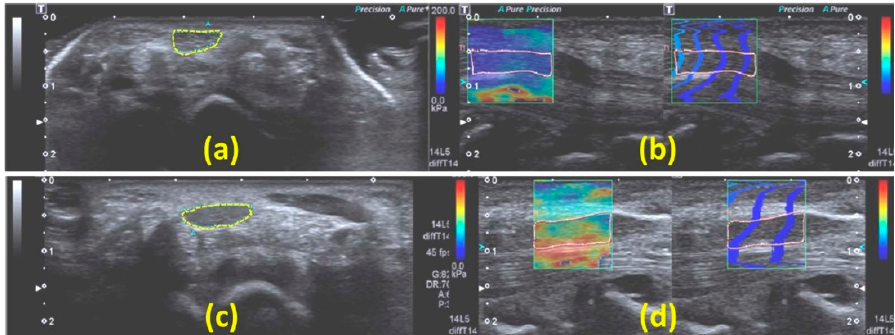
Figure 8. ( a , c ) B-mode images of the transverse plane of median nerves of a healthy subject and a CTS patient, respectively. The median nerve cross-section is identified by the dashed line. CSAs of the median nerve were 16 and 27 mm 2 for the healthy subject and CTS patient, respectively. ( b , d ) SWE-based stiffness and propagation maps from SWE on the longitudinal planes of the median nerves of the same healthy subject ( b ) and CTS patient ( d ), respectively. The average stiffnesses measured along the longitudinal plane of the median nerve were 35 and 113 kPa for the healthy subject and CTS patient, respectively. These figures were previously presented by Cingoz et al. [52]. Reprinting permission is granted through Rightslink system. Minor modifications were performed for presentation purposes.